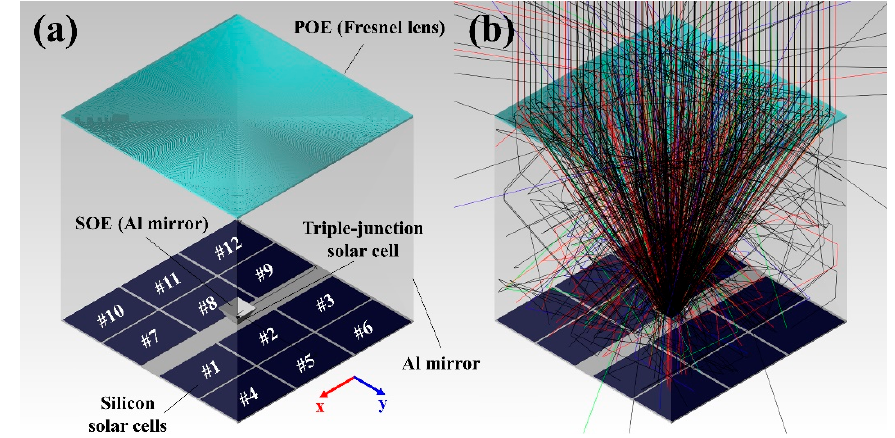
Figure 1. ( a ) The raytracing model and ( b ) raytracing results of the hybrid concentrator photovoltaic (CPV) module combined with low-cost silicon solar cells.